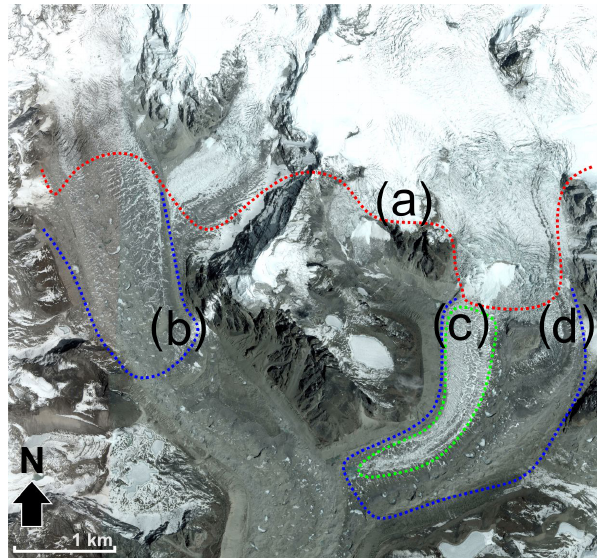
Figure 9. Distribution of crevasses on the W and NE branches of Ngozumpa Glacier. (a) Lower boundary of crevasse fields; (b, c, d) areas where supraglacial channels occur on debris-covered and clean (c) ice. Image source: Google